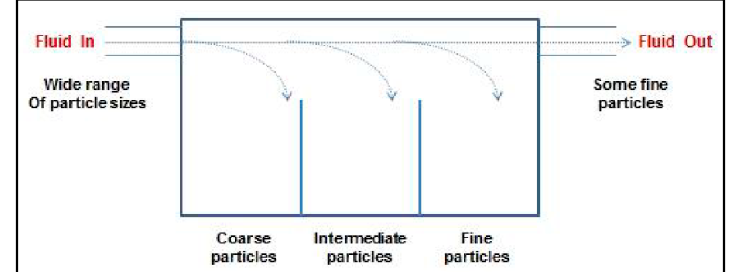
Figure 2. The principle of air-blower impurity sorting.